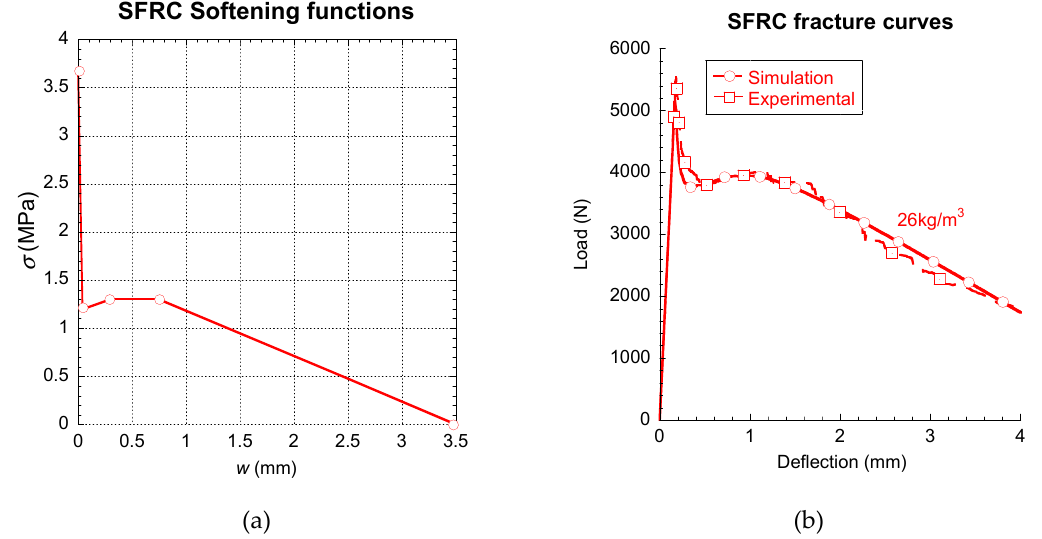
Figure 7. Softening function ( a ) and comparison between the simulated and experimental results ( b ).